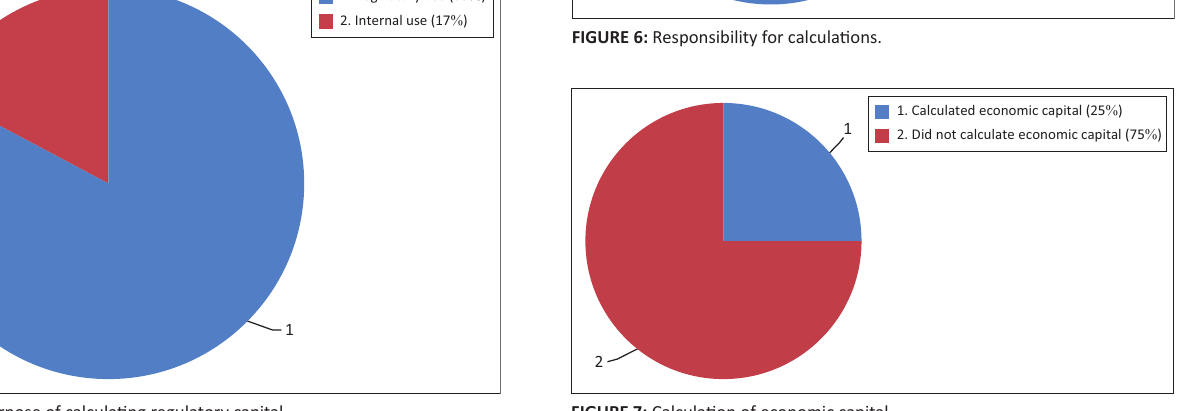
FIG URE 5: Purpose of calculating regulatory capital.